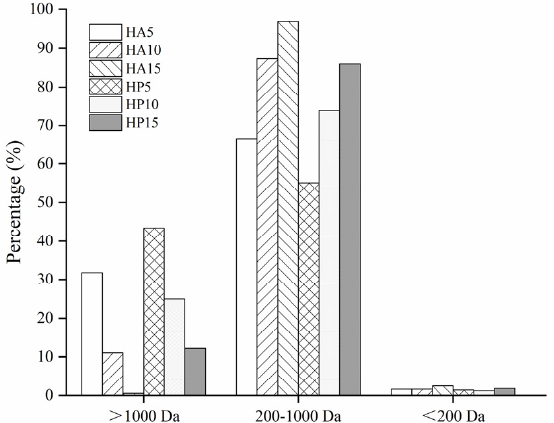
Figure 1. Molecular weight distribution of bone hydrolysates prepared by Alcalase and Protamex.